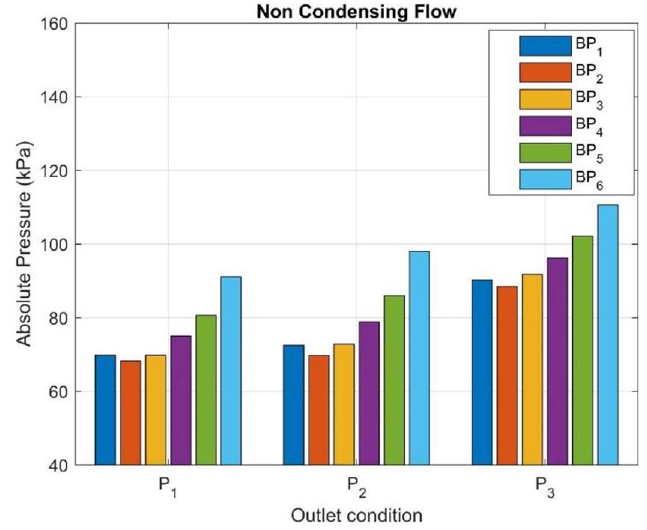
Figure 7. Axial pressure distribution in non-condensing flow.